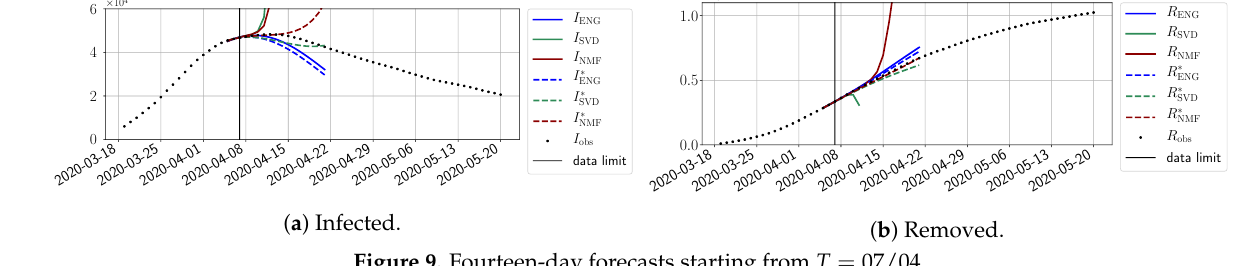
Figure 9. Fourteen-day forecasts starting from T = 07/04.